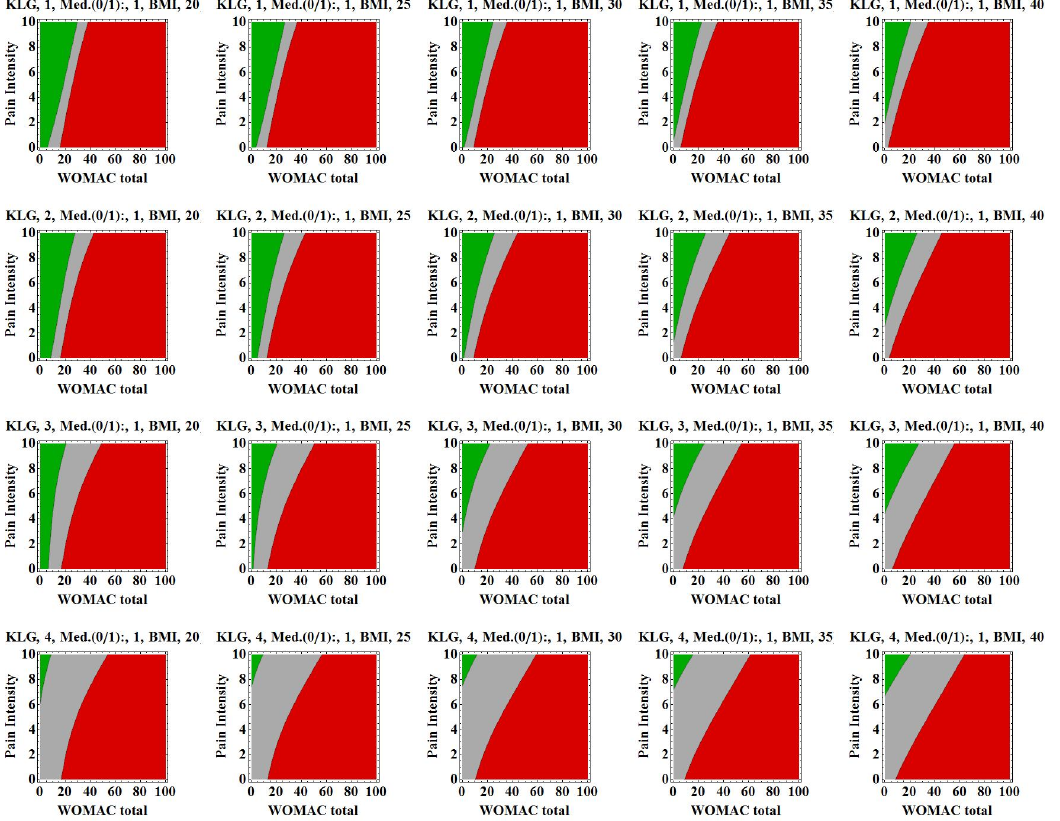
Figure 3. Graphic visualization of the neural network output illustrating the three-layer perceptron decision areas including the variables pain intensity, Kellgren and Lawrence grades, Western Ontario and McMaster Universities Osteoarthritis Index (WOMAC) total score, use of medication (Med.; 0 = taking no pain medication, 1 = taking pain medication) and body mass index into the neural network. Areas represent: green area = no TKR within next 2 years, red area = TKR within next 2 years and grey area = no prediction is made. The following scenario can be hypothesized: for a patient with a Kellgren and Lawrence grade of 1, a body mass index of 25 kg / m 2 , a WOMAC total score of 20 and a pain intensity of 8, it is predicted that TKR surgery is not appropriate within the next 2 years, according to previous decisions taken in the Osteoarthritis Initiative (OAI) population. BMI: Body Mass